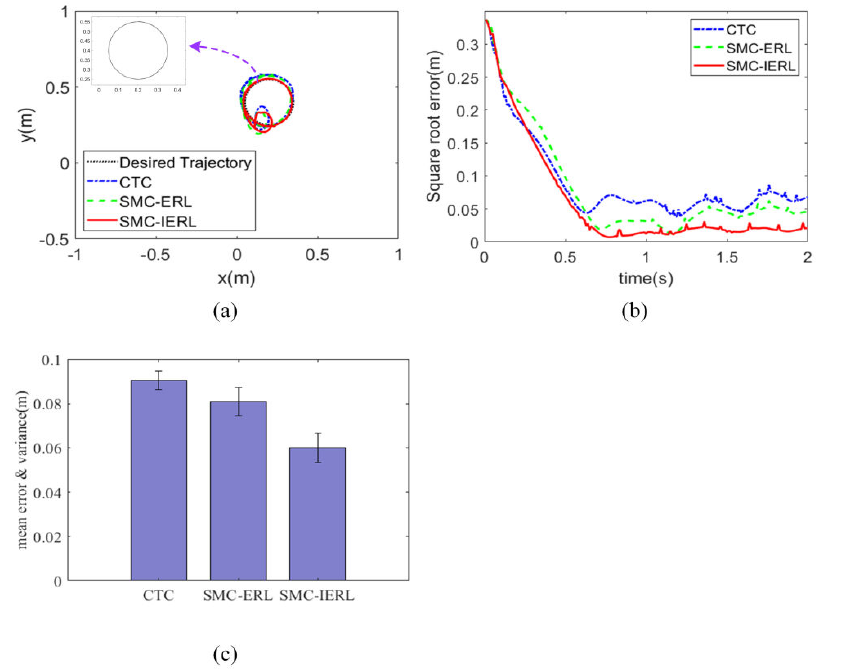
Figure 6. Uniform circular trajectory tracking experiment with disturbance signal. ( a ) comparison of trajectory tracking for desired uniform circular trajectory with three control algorithms; ( b ) compari- son of square root error of three control algorithms; ( c ) comparison of mean error and variance of three control